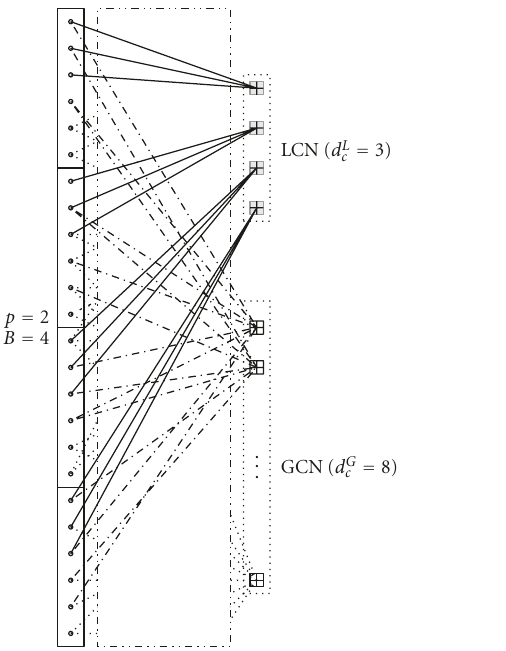
Figure 1: Tanner graph of the H matrix in (12), illustrating local and global check